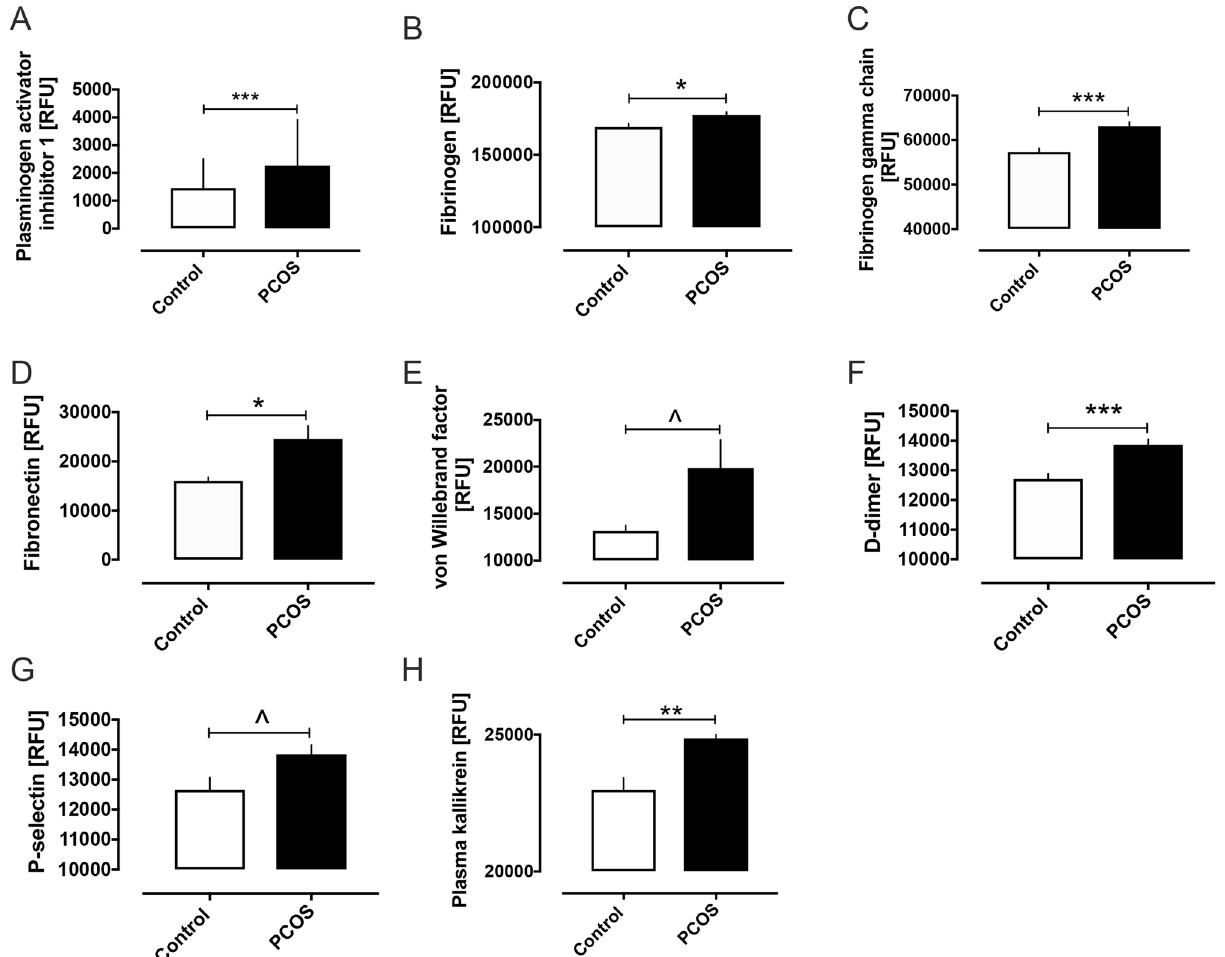
Figure 1. Pro-coagulation clotting pathway proteins that were increased in women with polycystic ovary syndrome (PCOS). Levels of plasma plasminogen activator inhibitor 1 ( A ), fibrinogen ( B ), fibrinogen gamma chain ( C ), fibronectin ( D ), von Willebrand factor ( E ), D-dimer ( F ), P-selectin ( G ) and plasma kallikrein ( H ) in women with and without polycystic ovary syndrome (PCOS). RFU, relative fluorescent units. Graphs shown as